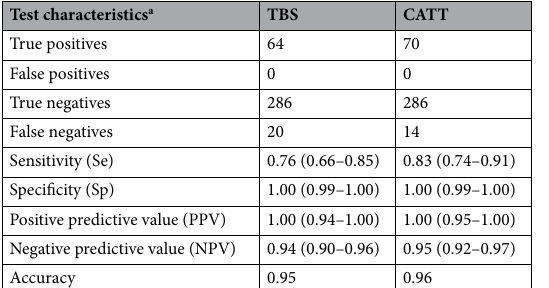
Table 3. Diagnostic test characteristics for thin blood smear (TBS) and card agglutination test for T. evansi (CATT) in 370 dromedary camels using PCR as the reference test. a Numbers in parentheses are 95% confidence intervals.